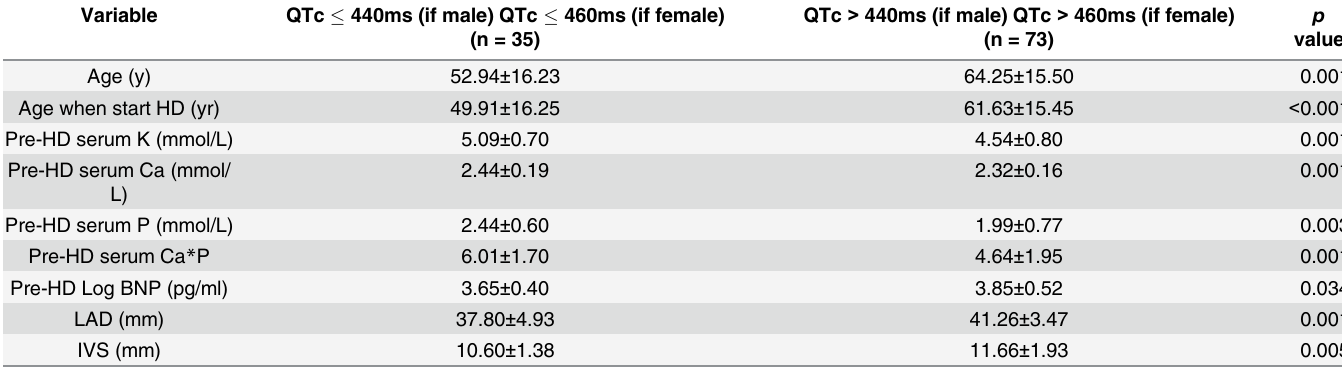
Table 4. Comparative analysis of variables according to the QT c interval in patients undergoing HD (n = 108).